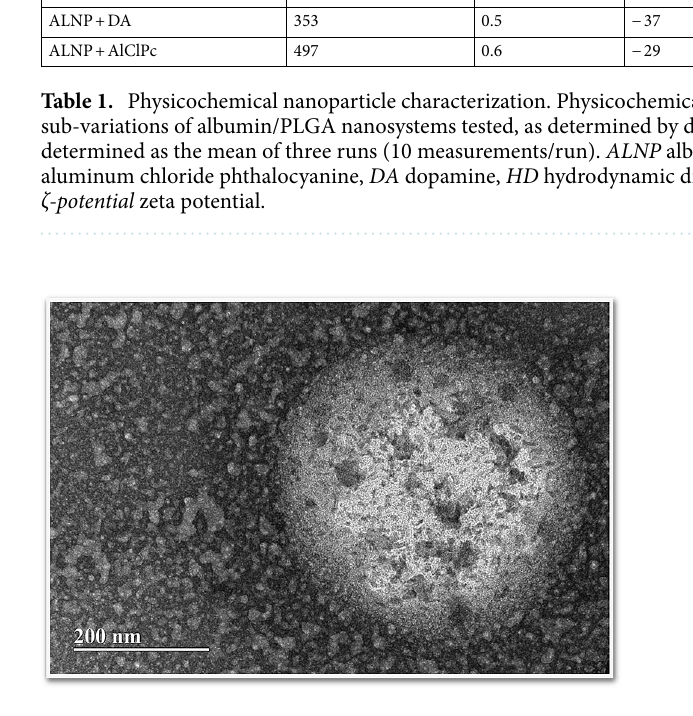
Figure 2. Nanosystem characterization. Transmission electron micrograph of a representative albumin/PLGA nanosystem, in this case, depicting a phthalocyanine-loaded albumin/PLGA (ALNP + AlClPc) nanosystem at 30,000× magnification showing spherical format and size of 466 nm. Scale bar: 200